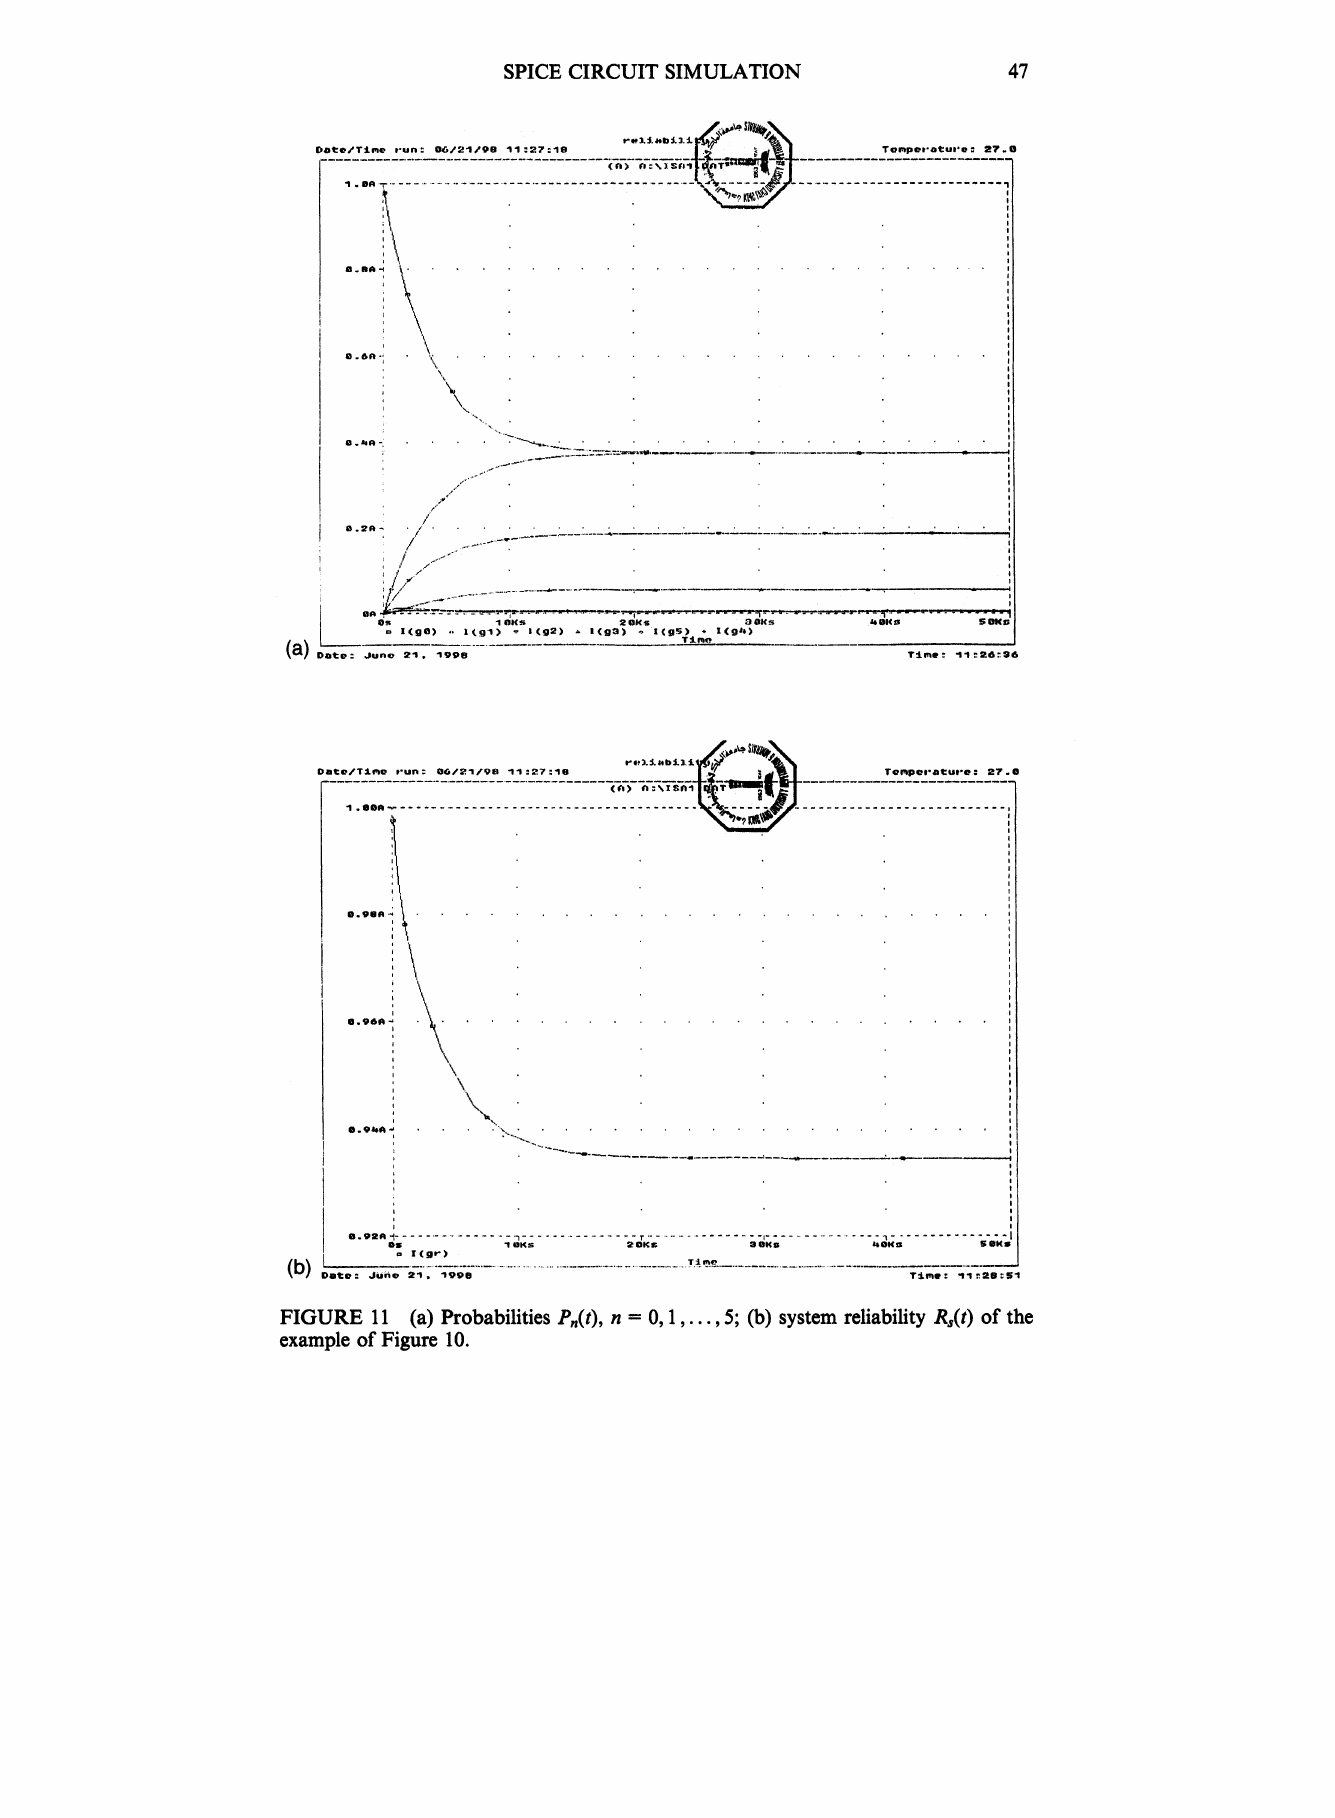
FIGURE 11 (a) Probabilities In(t), n 0,1,..., 5; (b) system reliability Rs(t) of the example of Figure